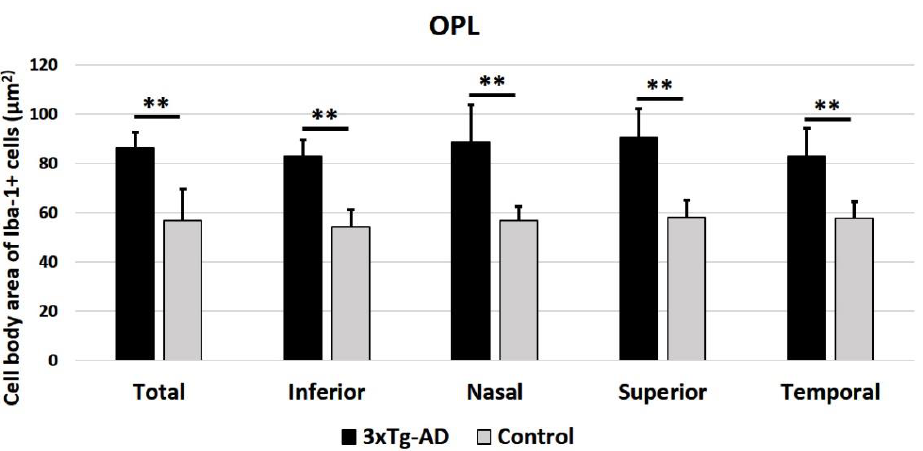
Figure 6. Cell body area of Iba-1 + cells in the outer plexiform layer (OPL), in 3xTg-AD, and in age- matched control mice in the different retinal zones (inferior, nasal, superior, and temporal), as well as in the total retina. A total of 576 microglial cells were measured for each study group (3xTg-AD and control). Histograms show the mean cell body area (± standard deviation, SD) of the Iba-1 + cells. Statistically significance indicators: ** p < 0.01.